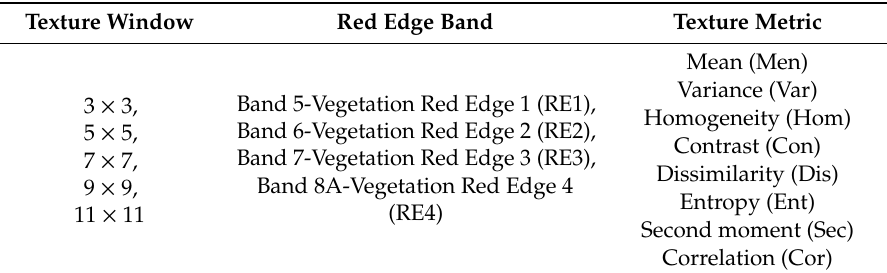
Table 6. Texture features extracted under di ff erent texture